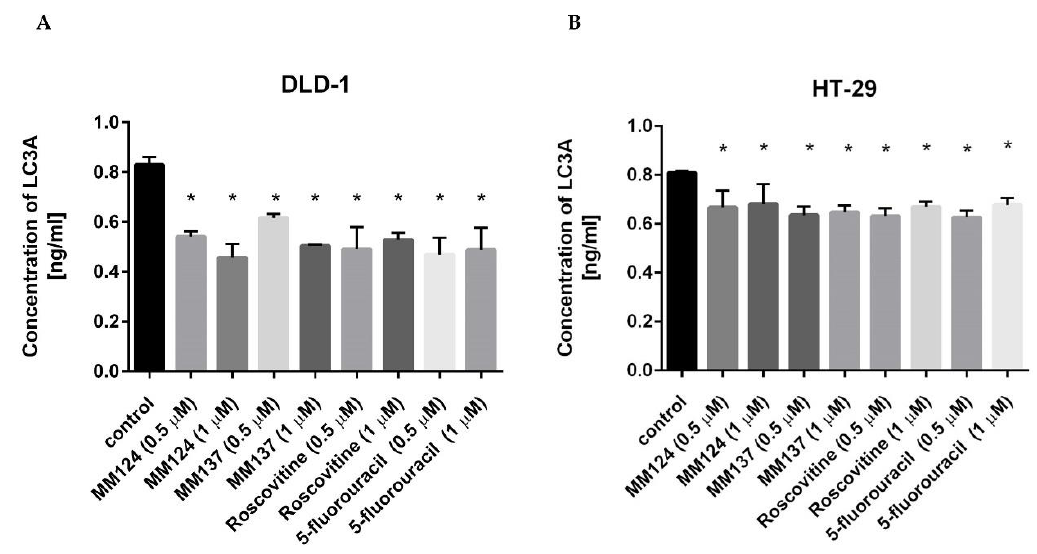
Figure 8. Concentration of LC3A in human DLD-1 ( A ) and HT-29 ( B ) human colorectal cancer cells after 24 h incubation with novel 7-methyl-5-phenyl-pyrazolo[4,3- e ]tetrazolo[4,5- b ][1,2,4]triazine sulfonamide derivatives (MM124, MM137), 5-fluorouracil, and roscovitine. Data is presented as mean ± SD from three independent experiments done in duplicate. * p < 0.05 vs. control group.